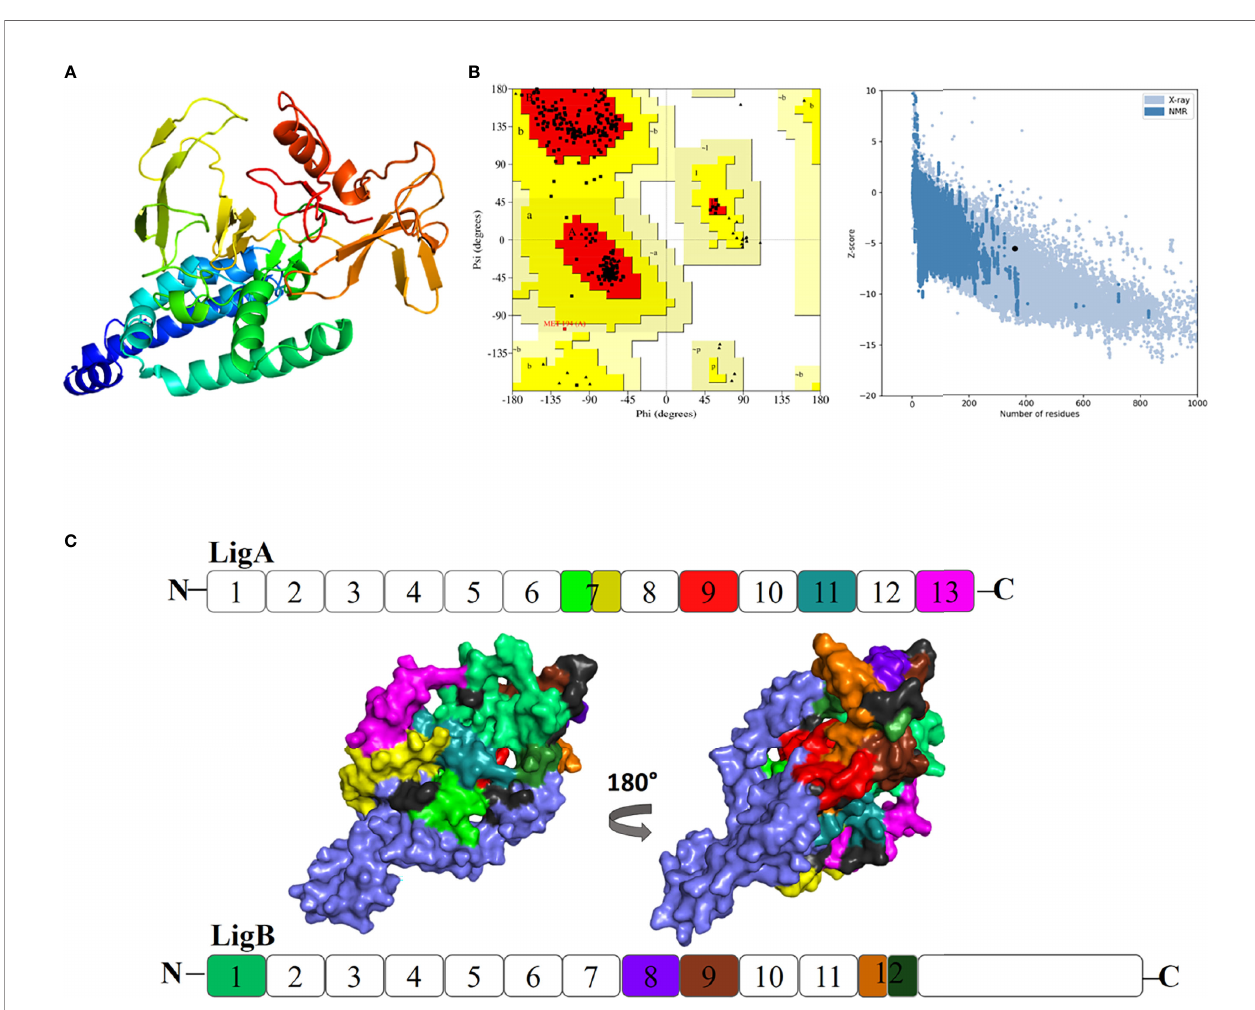
FIGURE 4 | (A) Three-dimensional (3D) model of the vaccine construct. (B) Plot showing validation of the 3D model using Ramachandran plot and the ProSA server. (C) Promiscuous epitopes used in the vaccine construct are mapped with the same colour code on the Ig-like domains of Lig proteins, LigA and LigB. The N and C represent as amino and carboxy termini of the protein,